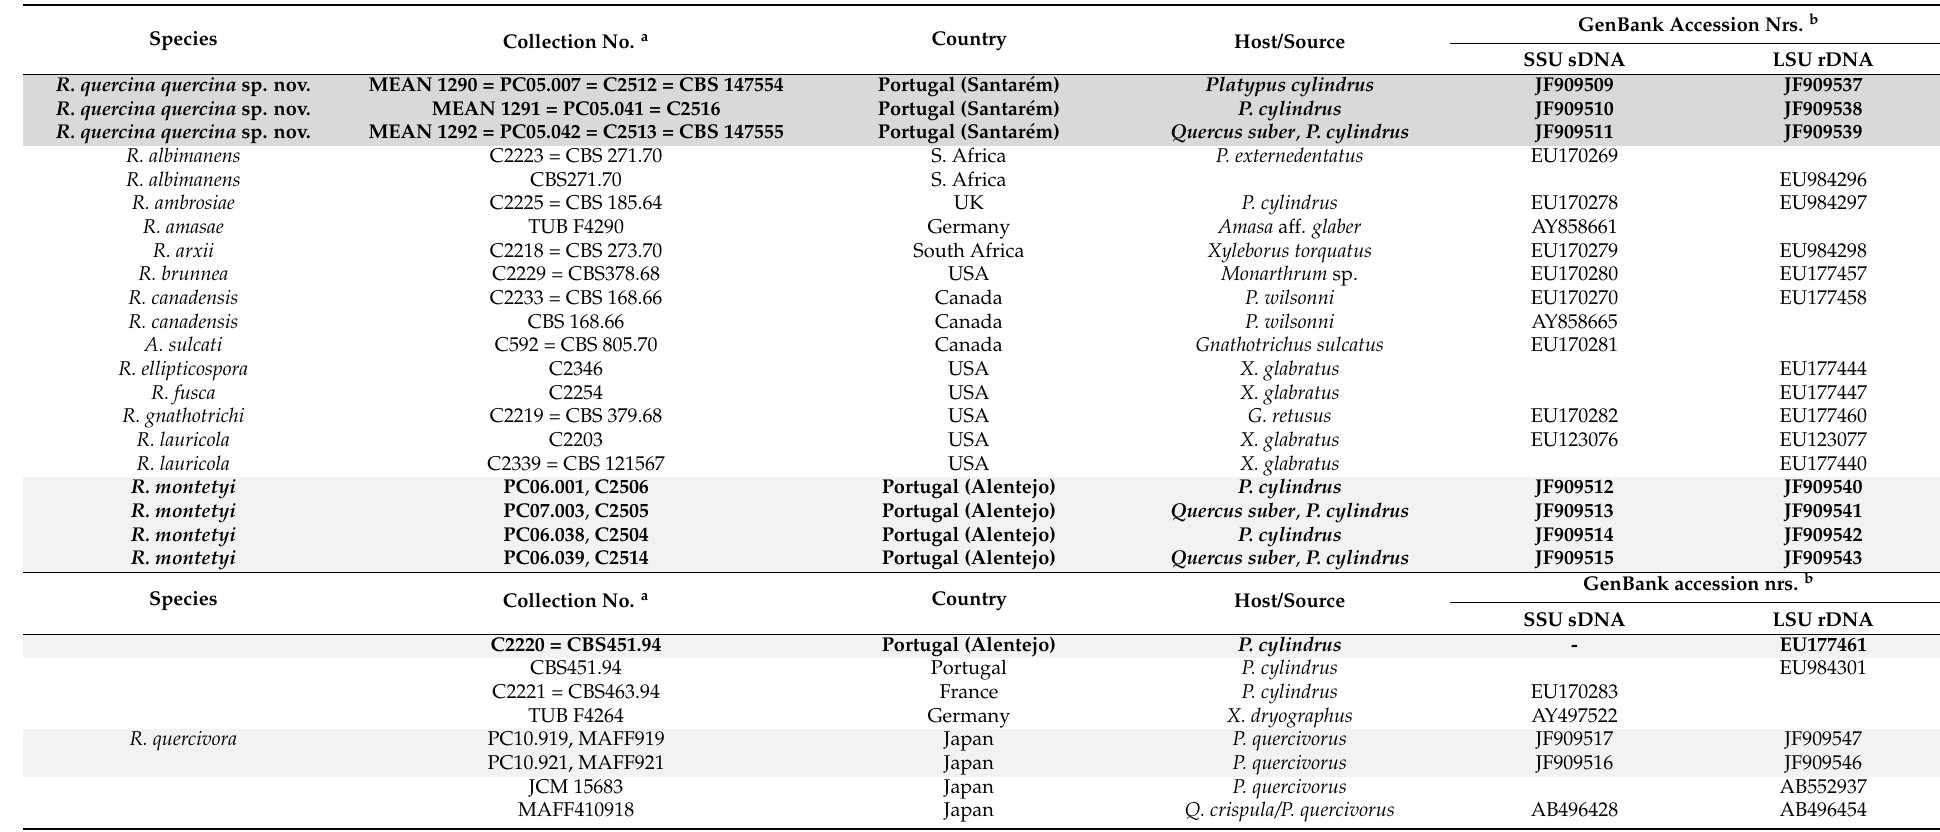
Table 1. Details of Raffaelea isolates obtained in this study (bold) and of strains representing species of Raffaelea retrieved from GenBank and used in phylogenetic analyses. Species